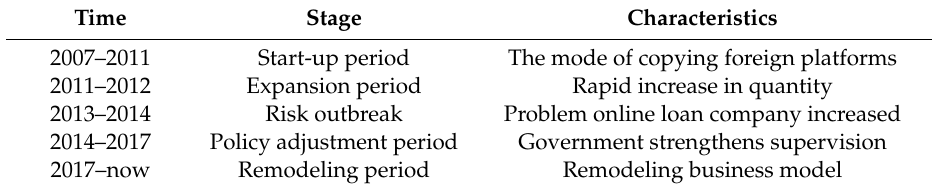
Table 1. Basic situation and stage division of China’s peer-to-peer (P2P) development.